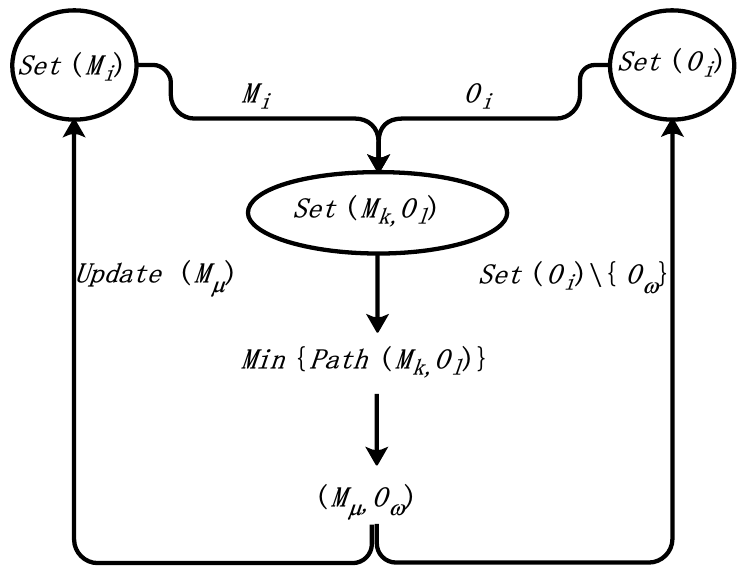
Figure 4. Multimobile service node scheduling